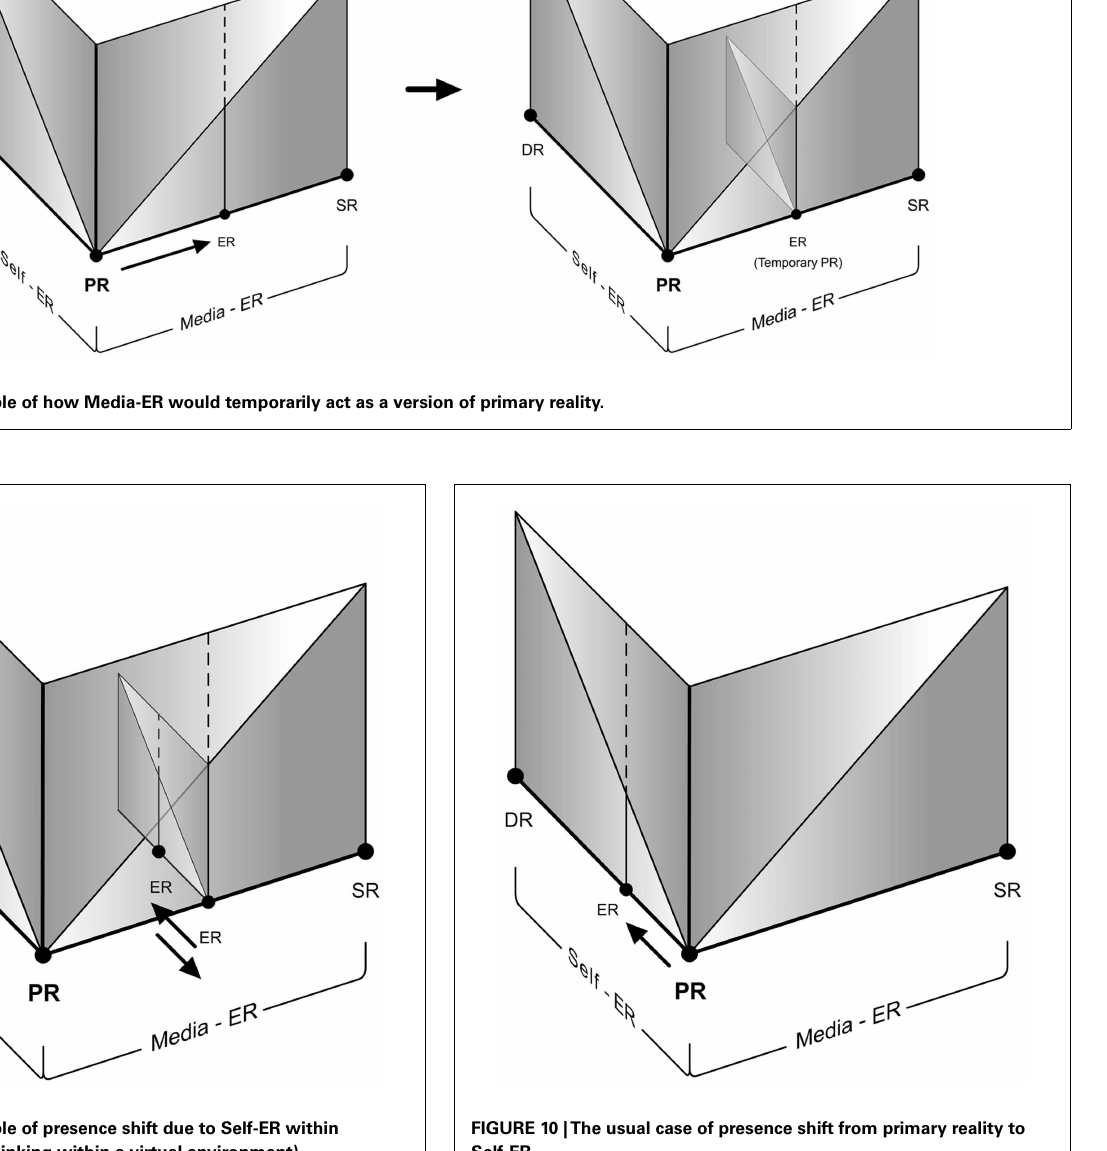
during mind-wandering or an EP oscillating between the Self-ER, Media-ER, and the Primary Reality.